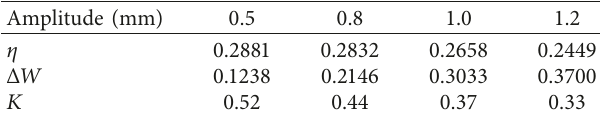
Table 3: Loss factor, energy dissipation, and dynamic average stiffness variation.